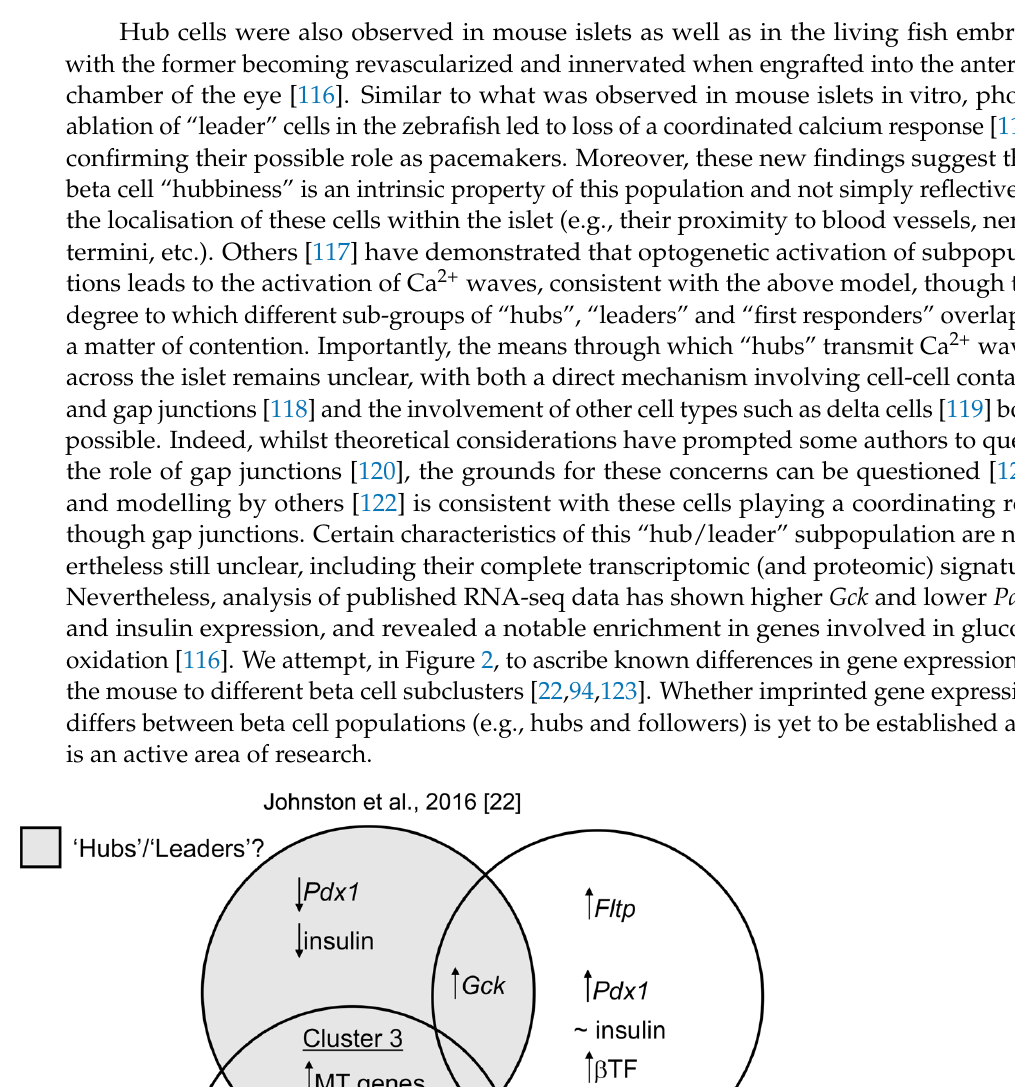
Figure 1. Beta cells display a heterogenous response to glucose including differences in excitability levels. A subpopulation of “hub” cells has been described that account for up to 10% of total beta cells. These “hub” cells, as opposed to “follower”